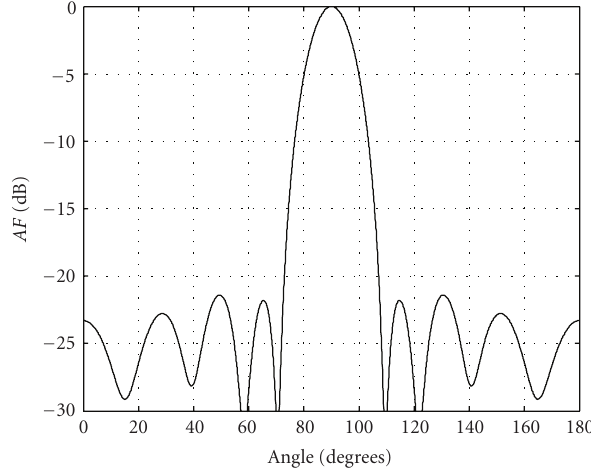
Figure 8: The attained pattern for the constant amplitude design case.